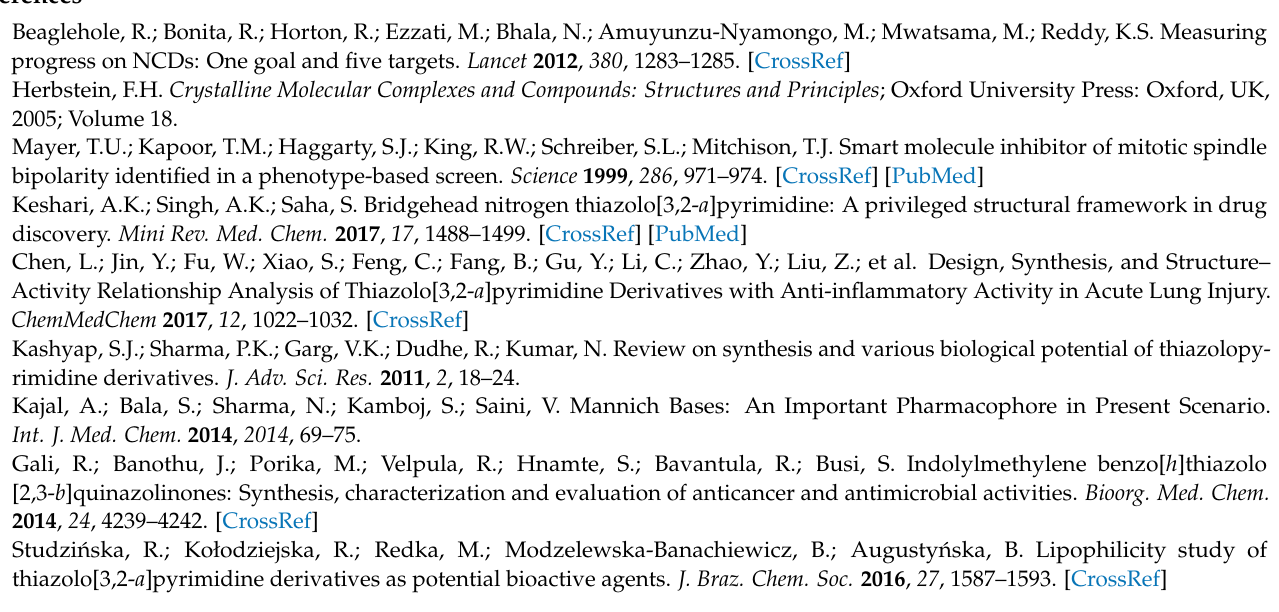
(DMSO-d6, 600 MHz); Figure S13: 13 C NMR spectrum of compound 3 (DMSO-d6, 600 MHz); Figure S14: MALDI TOF spectrum of compound 3 (matrix: p-nitroaniline); Figure S15: IR spectrum of compound 3 (KBr tablet); Figure S16: DSC curves of crystal 3a ; Figure S17: HRMS spectrum of compound 3